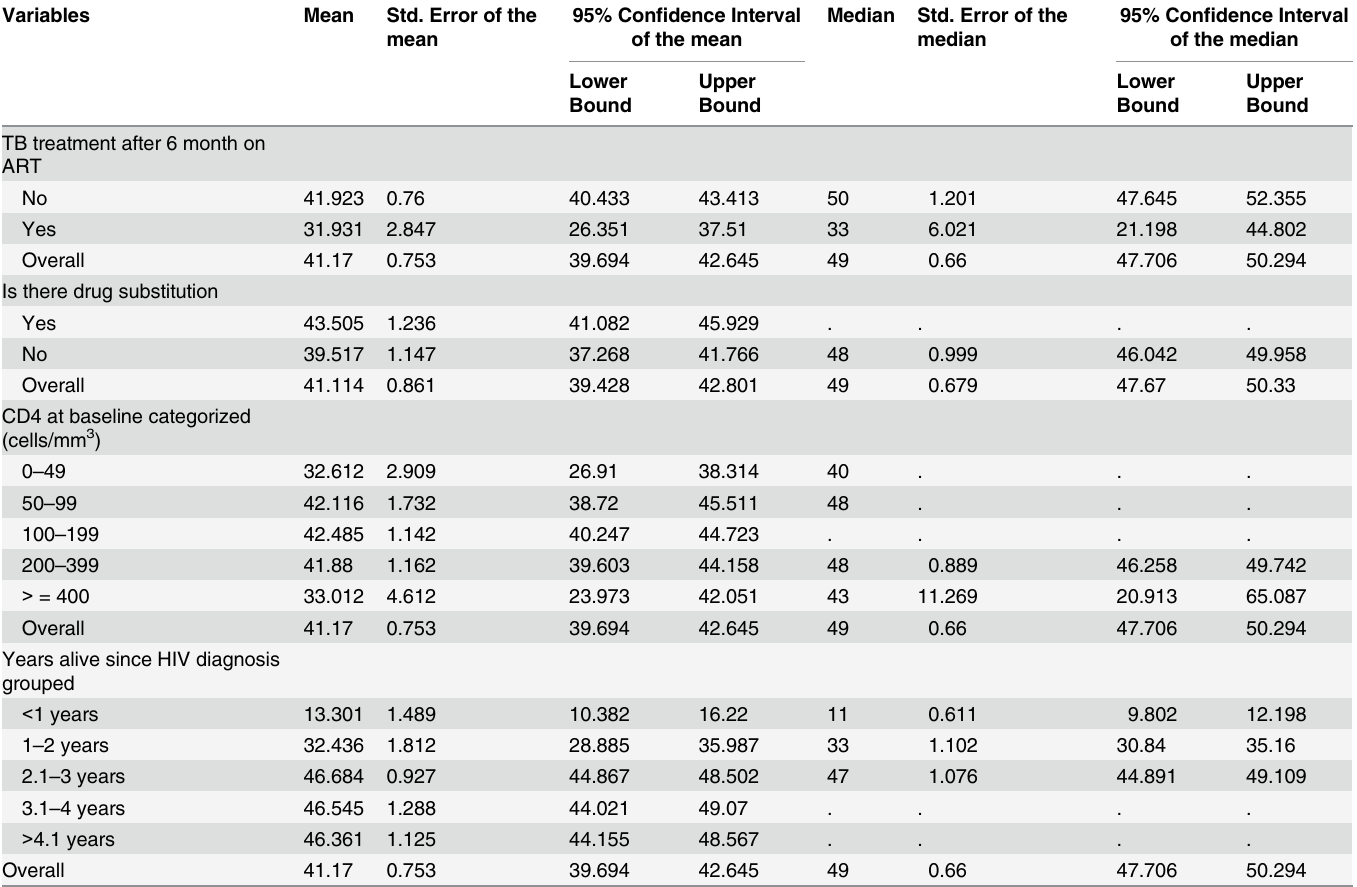
Table 5. Means and Medians for Survival Times for groups of different variables on ART patients in private health facilities in Addis Ababa, 2009 – 2013. Variables Mean Std. Error of the